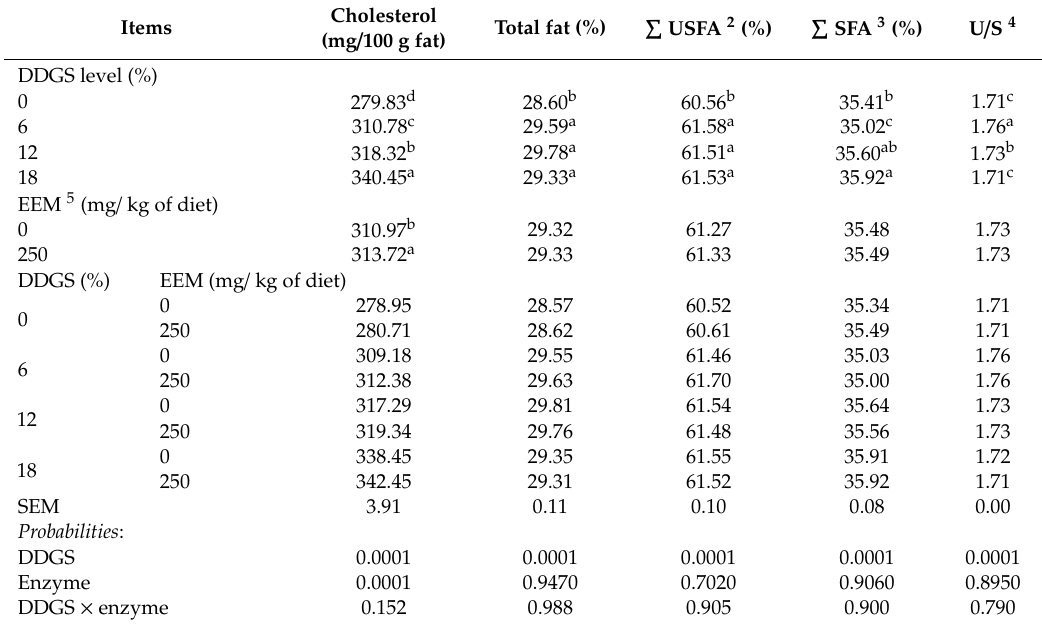
Table 5. The chemical composition of yolk lipids of laying hens organized by DDGS 1 inclusion levels and enzyme supplementation through 32–42 weeks of